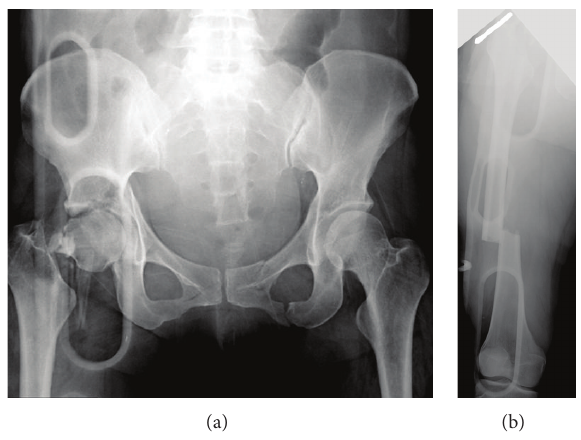
Figure 3: A postoperative radiograph of the femur. Retrograde intramedullary nailing for the right femoral shaft fracture and multiple cannulated cancellous screw fixation for the femoral neck fracture are performed.